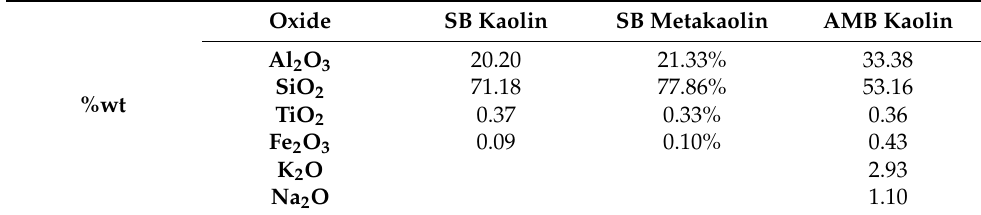
Table 1. Chemical analysis of kaolin and metakaolin samples used in this